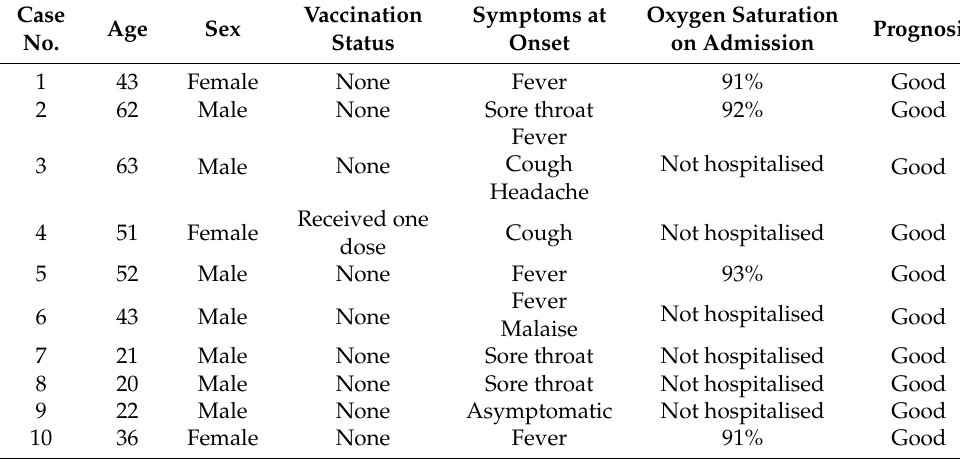
Table 4. Vaccination status, symptoms at onset, oxygen saturation on admission, and prognosis of PCR-positive